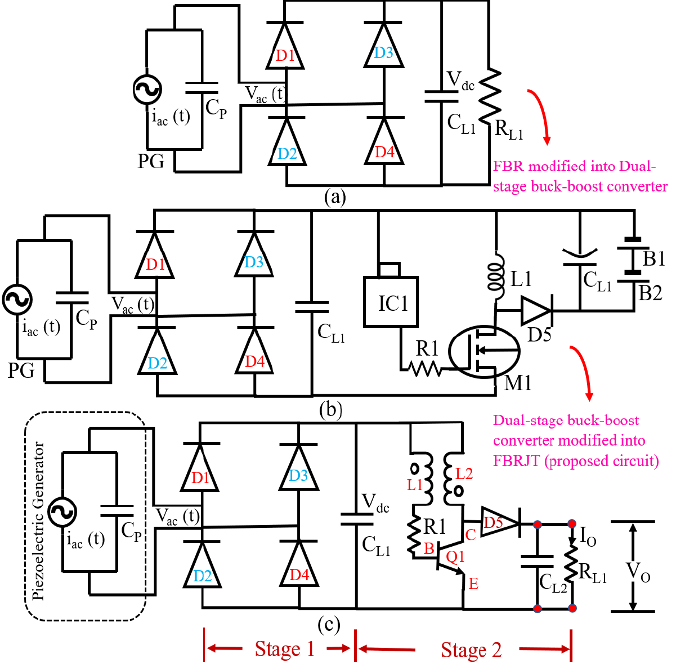
Figure 3. Enhancement procedure of the proposed circuit. ( a ) FBR, ( b ) Dual-stage buck-boost converter, ( c ) Proposed circuit, FBRJT, diodes, D1–D5; load capacitors, C L1–2 ; load resistors, R1, R L1 ; batteries, B1–2; inductors, L1, L2; switches, M1, Q1; base, collector, emitter, B, C, E; rectified, output voltage, output current, V dc , V O , I O .